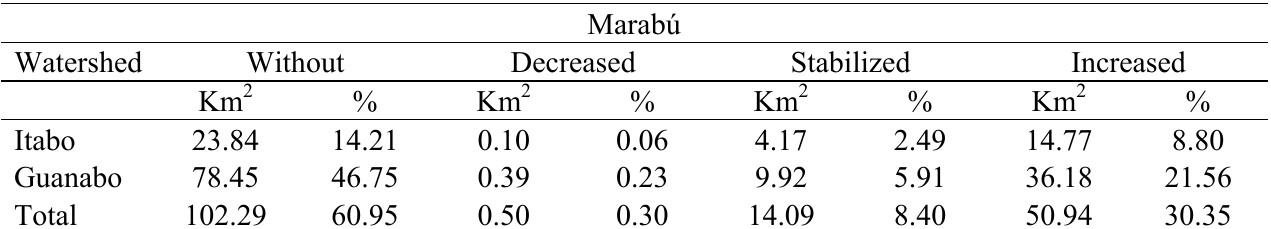
Table 1. The dynamics of the change in Marabú scrubland plants ( Dychrostachys cinerea ) in the area studied during the period 1985–2005.